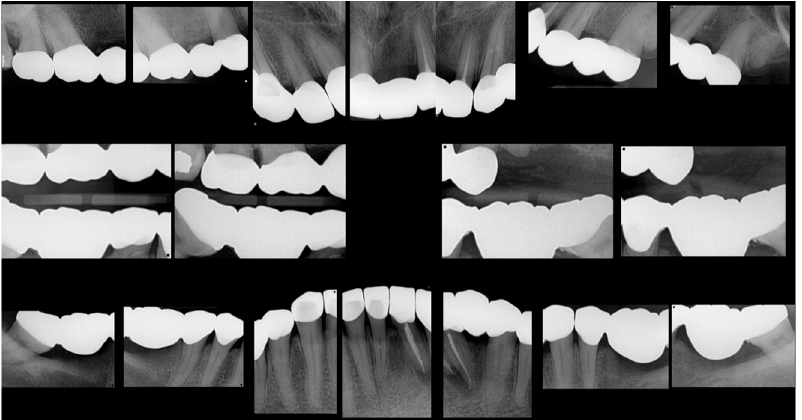
Figure 13. Full mouth radiograph series.